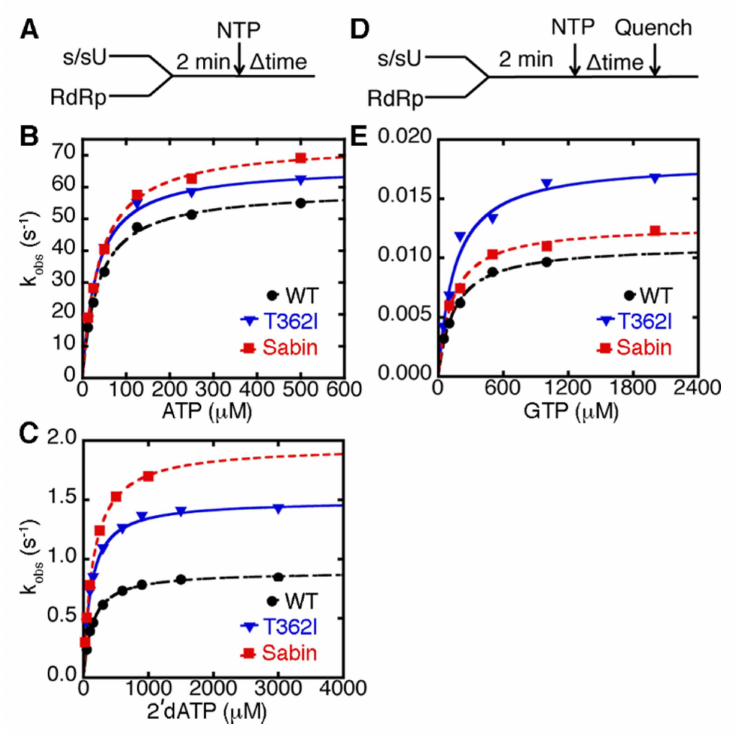
Figure 3. The Sabin I RdRp discriminates less against nucleotides with an incorrect 2 1 -deoxyribose sugar, but maintains nucleobase fidelity similar to WT enzyme ( A ) experimental design for the single nucleotide incorporation assay using ATP and 2 1 -dATP. RdRp (1 µ M) was pre-incubated with s/sU RNA (1 µ M), before being quickly mixed with equal volume of ATP or 2 1 -dATP with different concentrations. These reactions were monitored by fluorescence changes over time using a stopped-flow apparatus. Kinetic data for ( A ) AMP and ( B ) 2 1 -dAMP incorporation are plotted. The results for WT, T362I, and Sabin RdRp are shown in black, blue, and red, respectively. The lines represent data fit to a hyperbola function to give an apparent dissociation constant ( K d,app ) and a maximal rate constant for nucleotide incorporation ( k pol ); ( D ) the experimental design for the single nucleotide incorporation assay using GTP. RdRp (1 µ M) was pre-incubated with s/sU RNA (1 µ M) at room temperature for 3 min and then at the assay temperature of 30 ˝ C for 2 min, before being quickly mixed with equal volume of GTP at different concentrations. In this case, RNA was 32 P labeled on 5 1 -end; and ( E ) kinetic data for GMP incorporation are plotted in black, blue, and red for WT, T362I and Sabin RdRp respectively. The lines represent data fit to a hyperbola function to yield K d,app and k pol